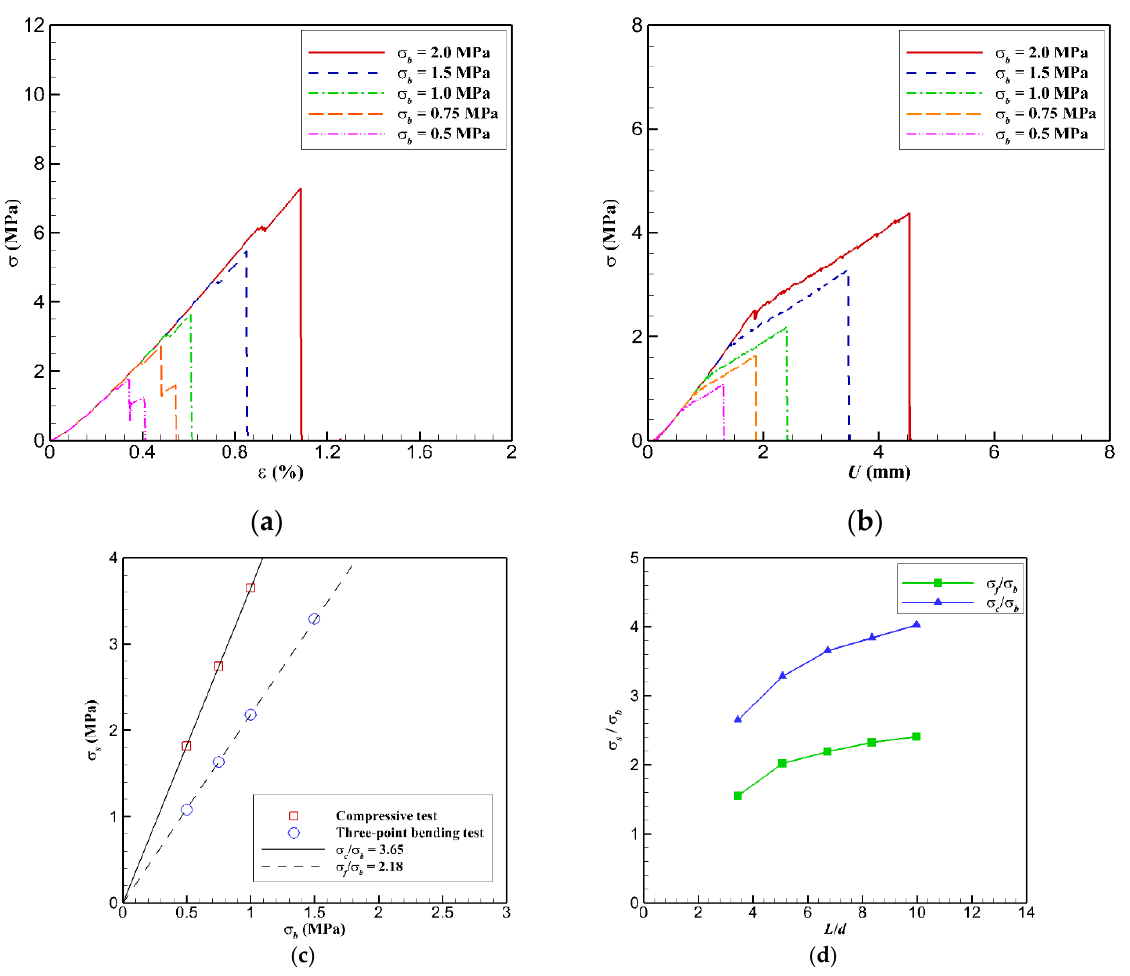
Figure 11. Effect of bond strength: ( a ) stress–strain curve; ( b ) stress–deflection curve; ( c ) ratio of simulated strength to bond strength; ( d ) effect of relative particle size.